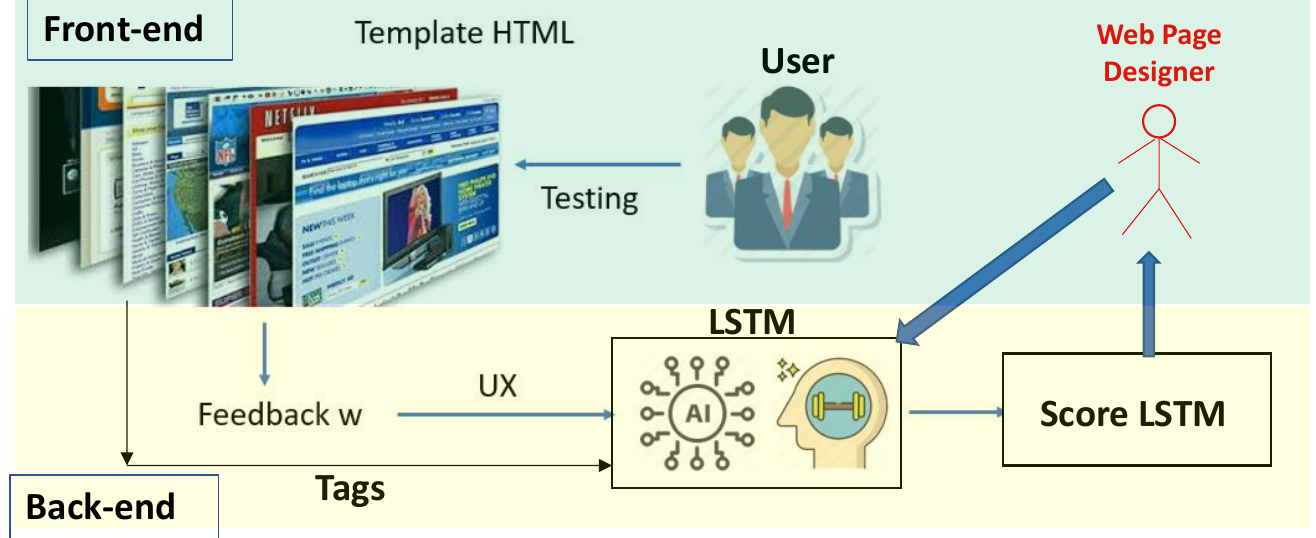
Figure 1. Front-end and back-end architecture of the platform “ ANDUIA